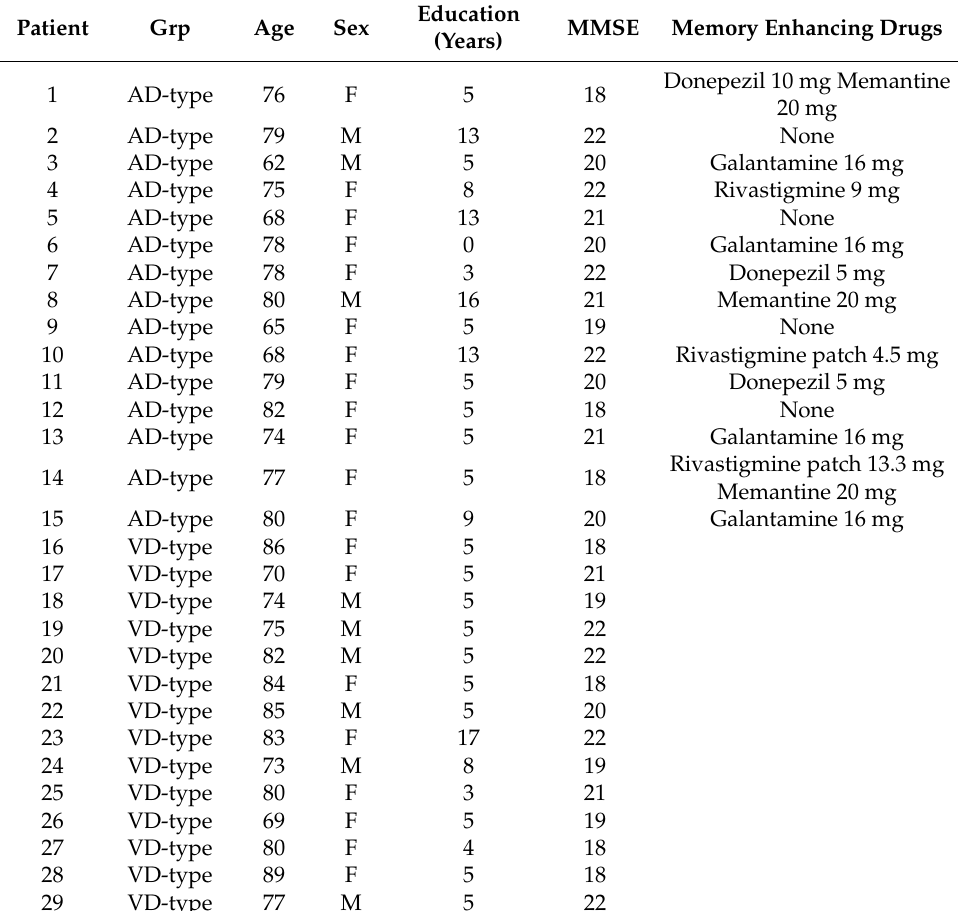
Table 1. Patients’ demographic data and score on cognitive